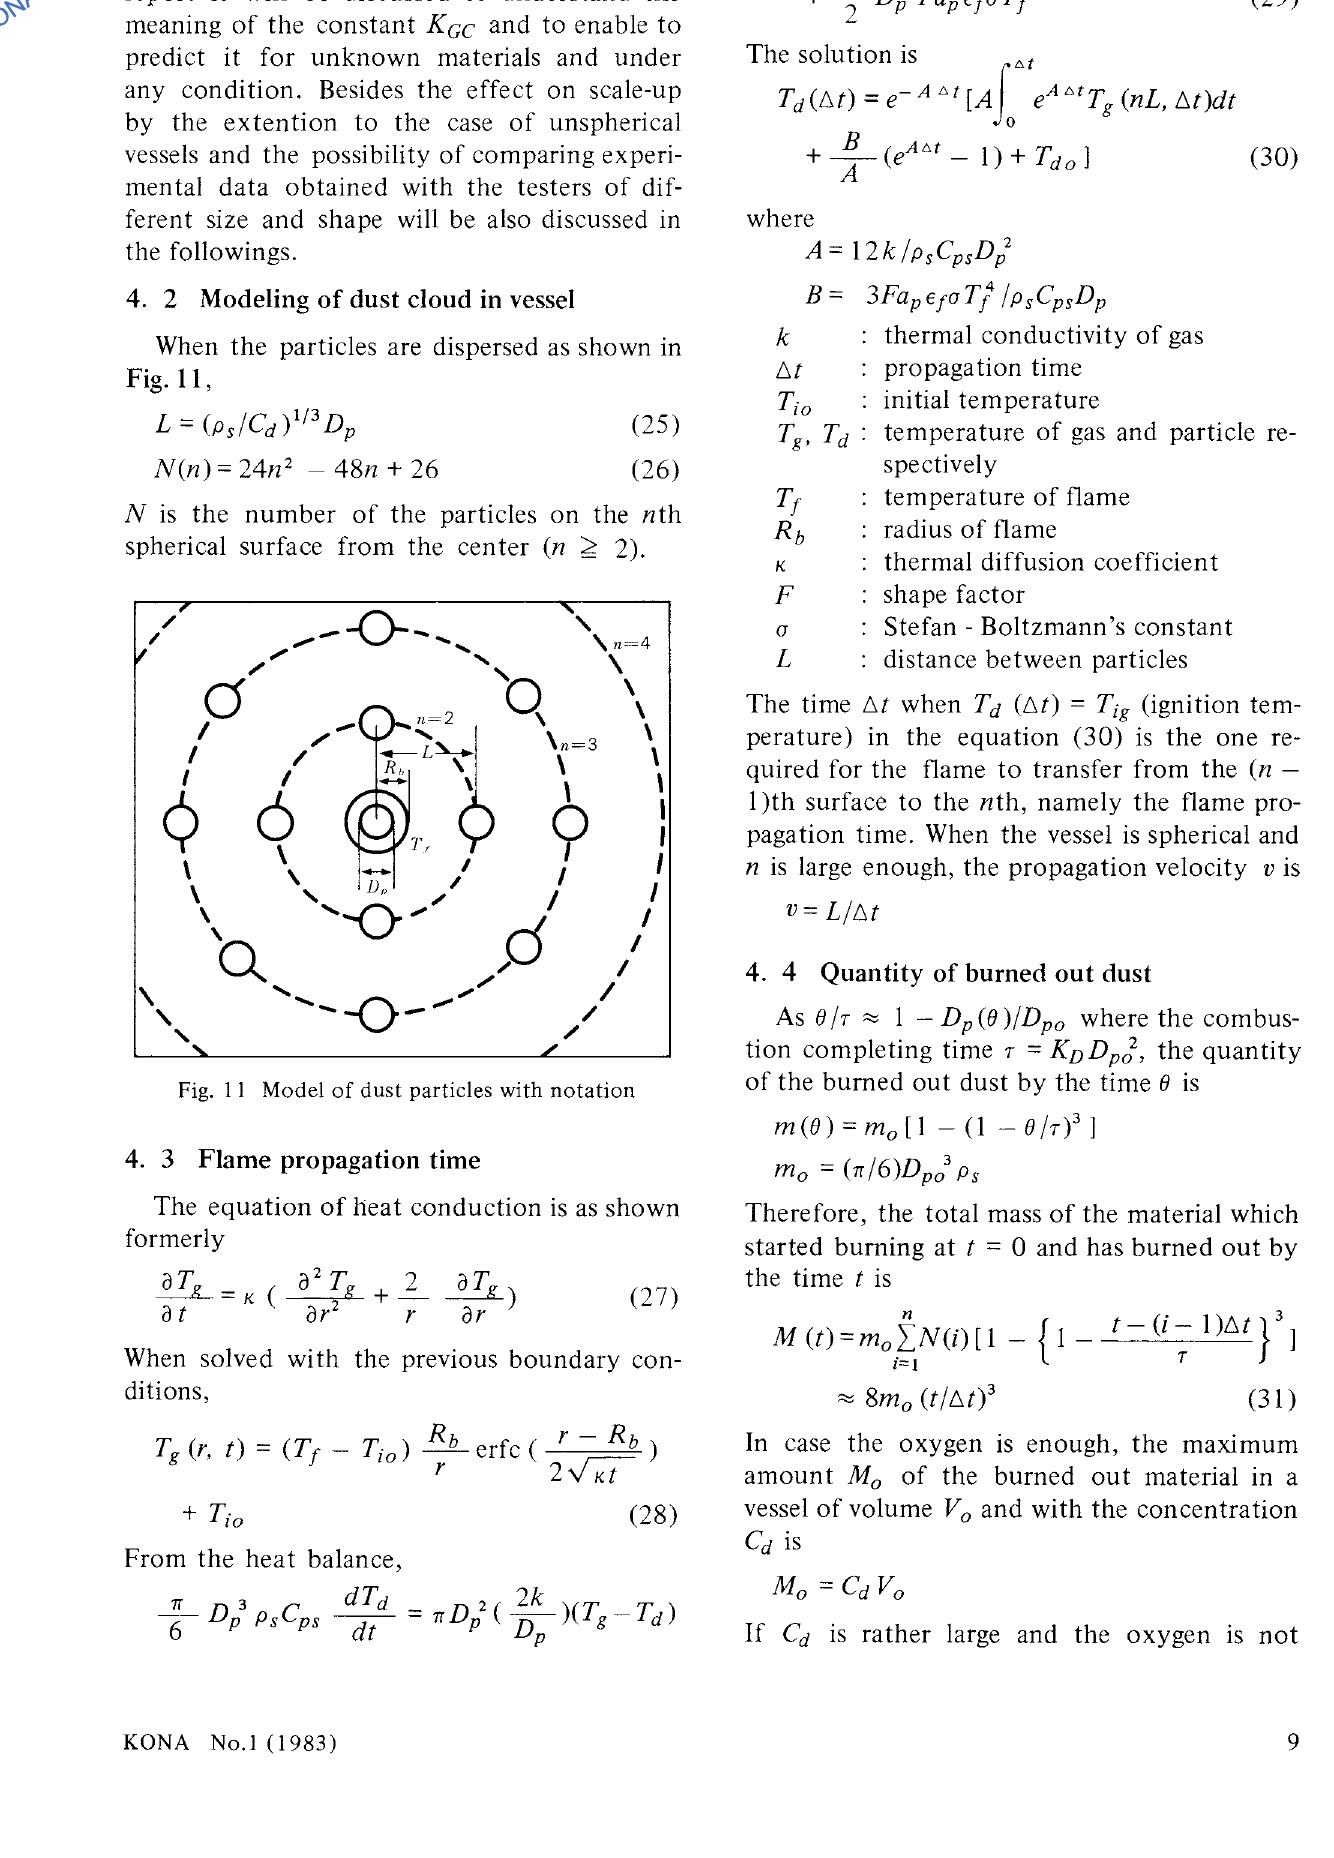
Fig. II Model of dust particles with